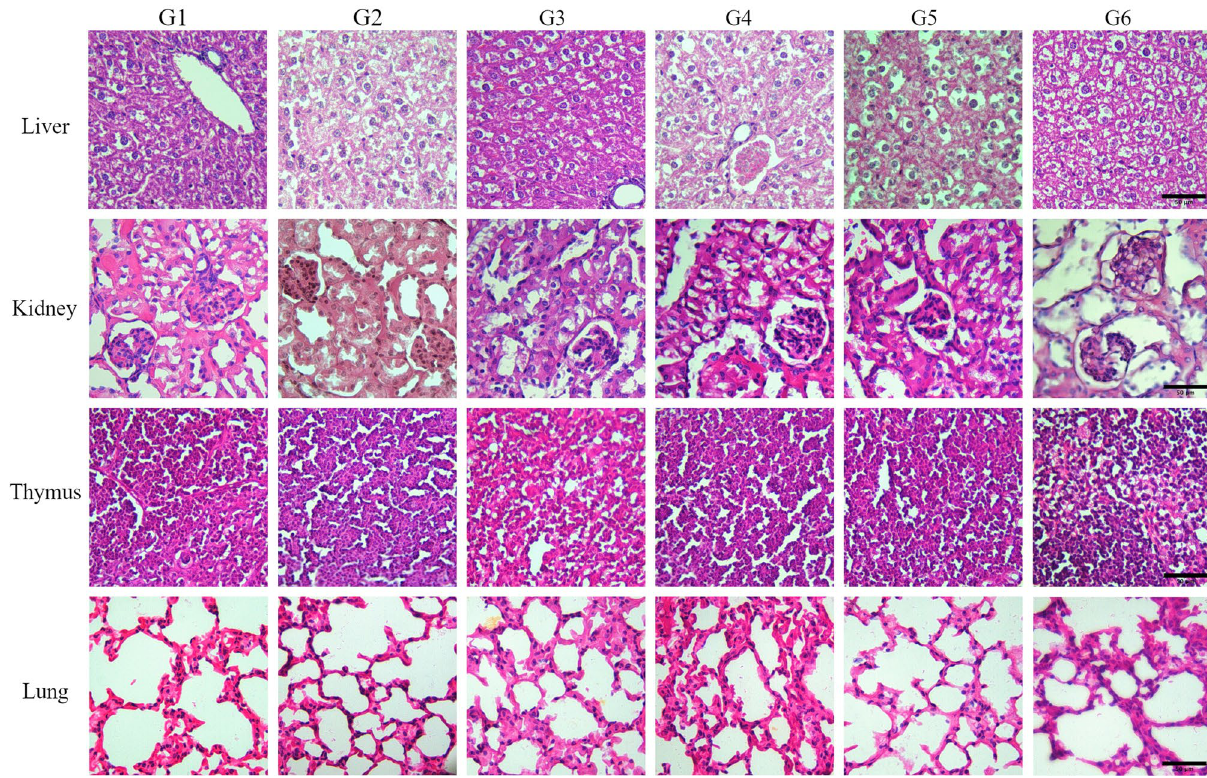
Figure 4. Histopathological analysis of different organ tissues from mice treated with ConvitVax. Liver, kidney, lung and thymus slides were processed and stained with H&E. Images shown are with 40X objective. Scale bar 50